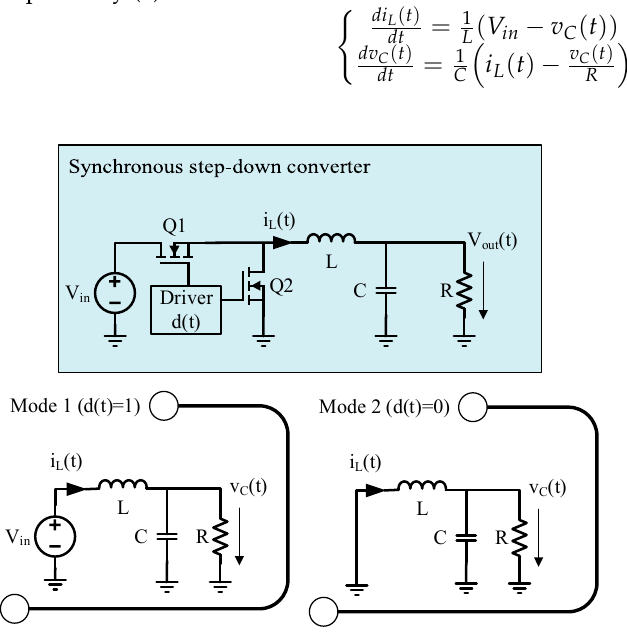
Figure 2. Ideal synchronous step-down (buck) converter model and its operating modes.